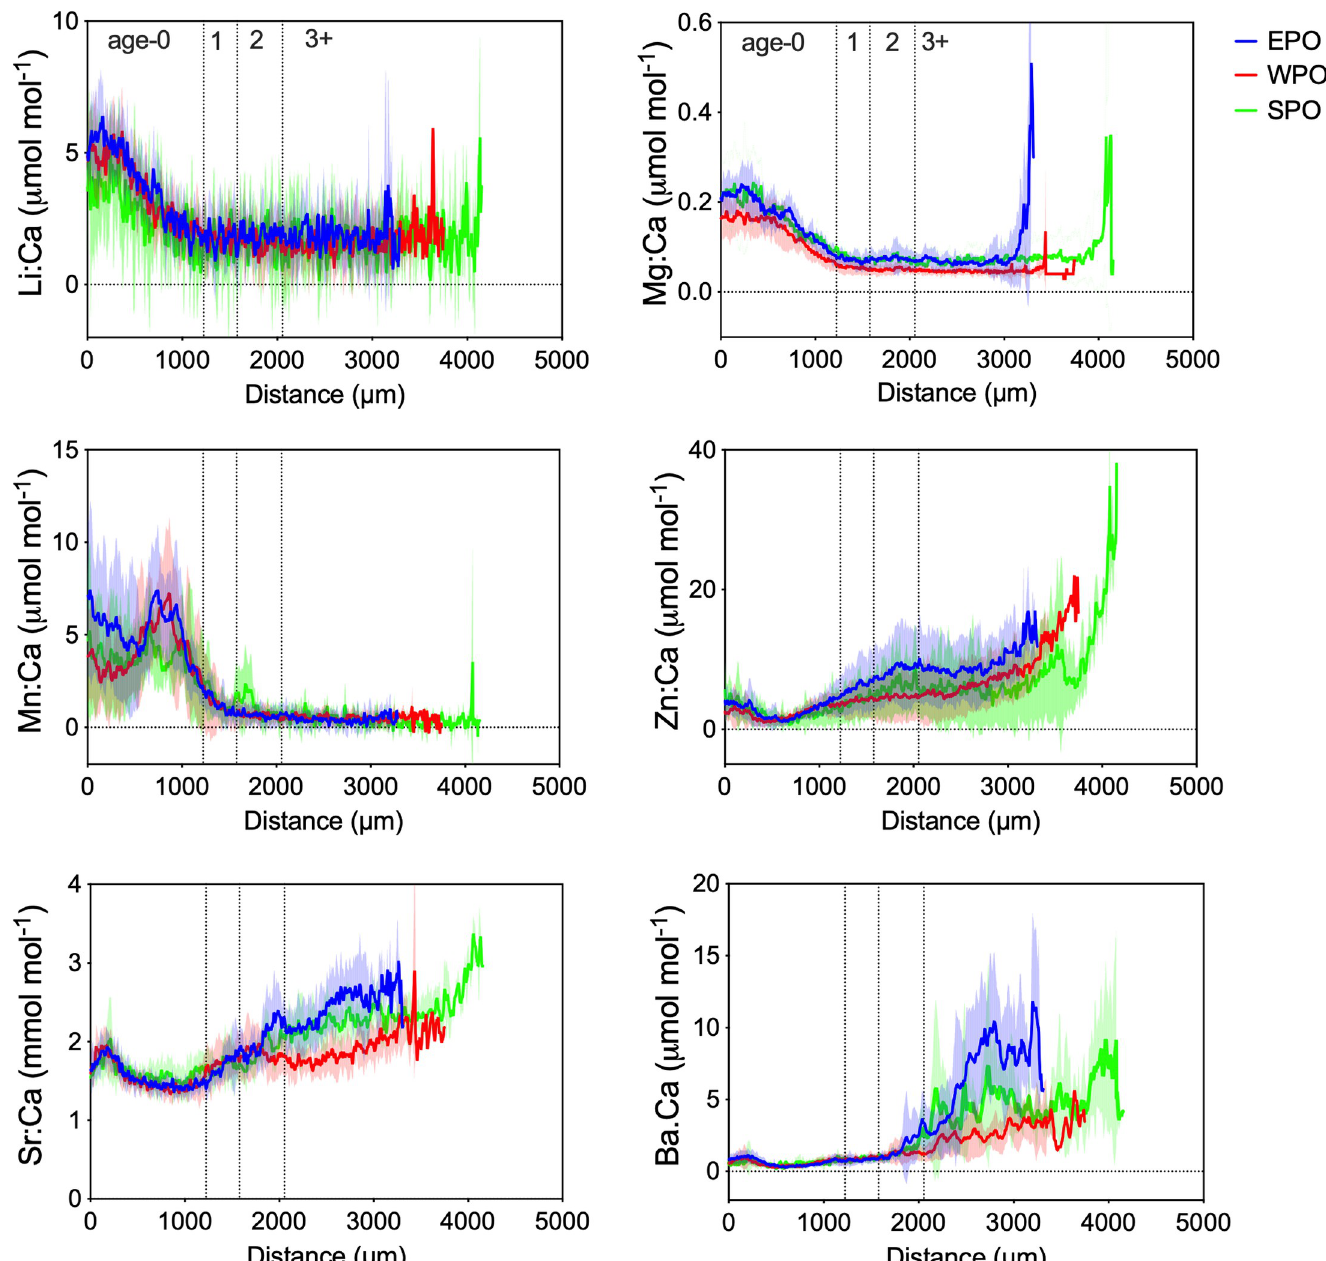
Fig 3. Mean element:Ca profiles for otoliths of Pacific bluefin tuna. (see Table 1 for fish collection details) collected from the eastern Pacific (EPO = blue, N = 10), western Pacific (WPO = red, N = 10), and south Pacific (SPO = green, N = 5) Ocean; solid lines represent mean values and shading depicts ± standard deviation across laser distance from core (0 μ m) to edge; dashed vertical lines denote approximate annuli distances derived from [35].